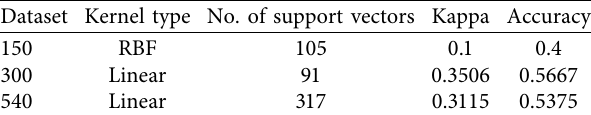
Table 8: Support vector machine training.